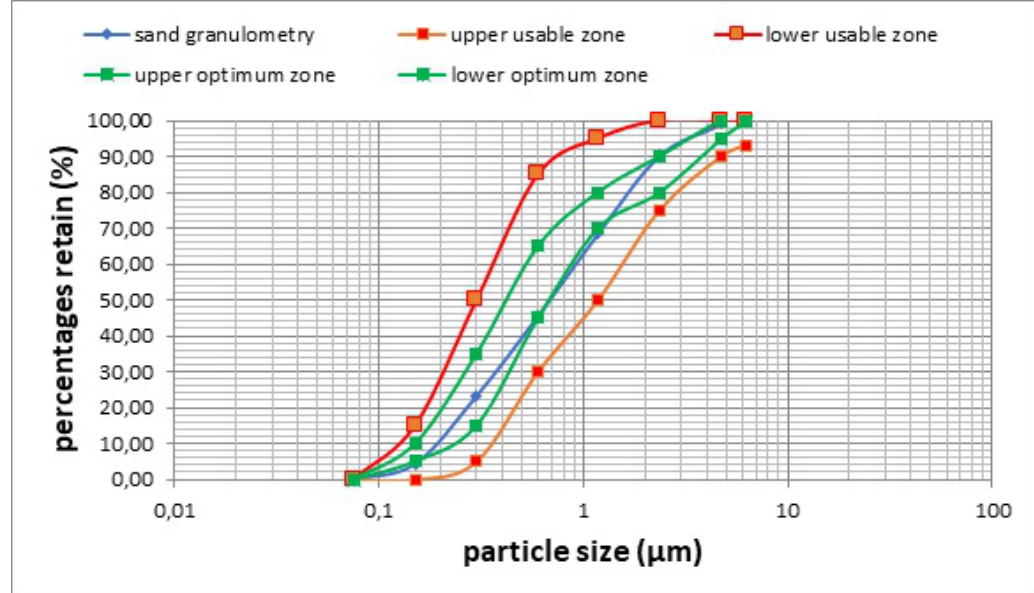
Figure 1. Granulometric curve of fine